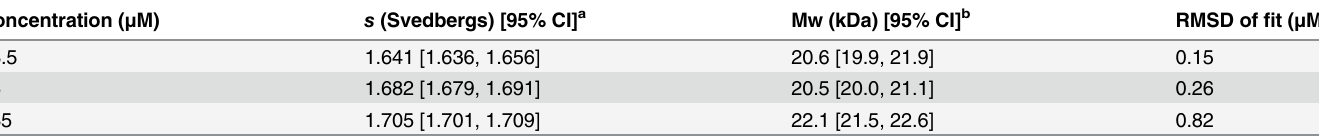
Table 1. Results for individually fitting the sedimentation velocity data to the model of a single ideal species by the program Sedfit (version 8.7). Concentration ( μ M)